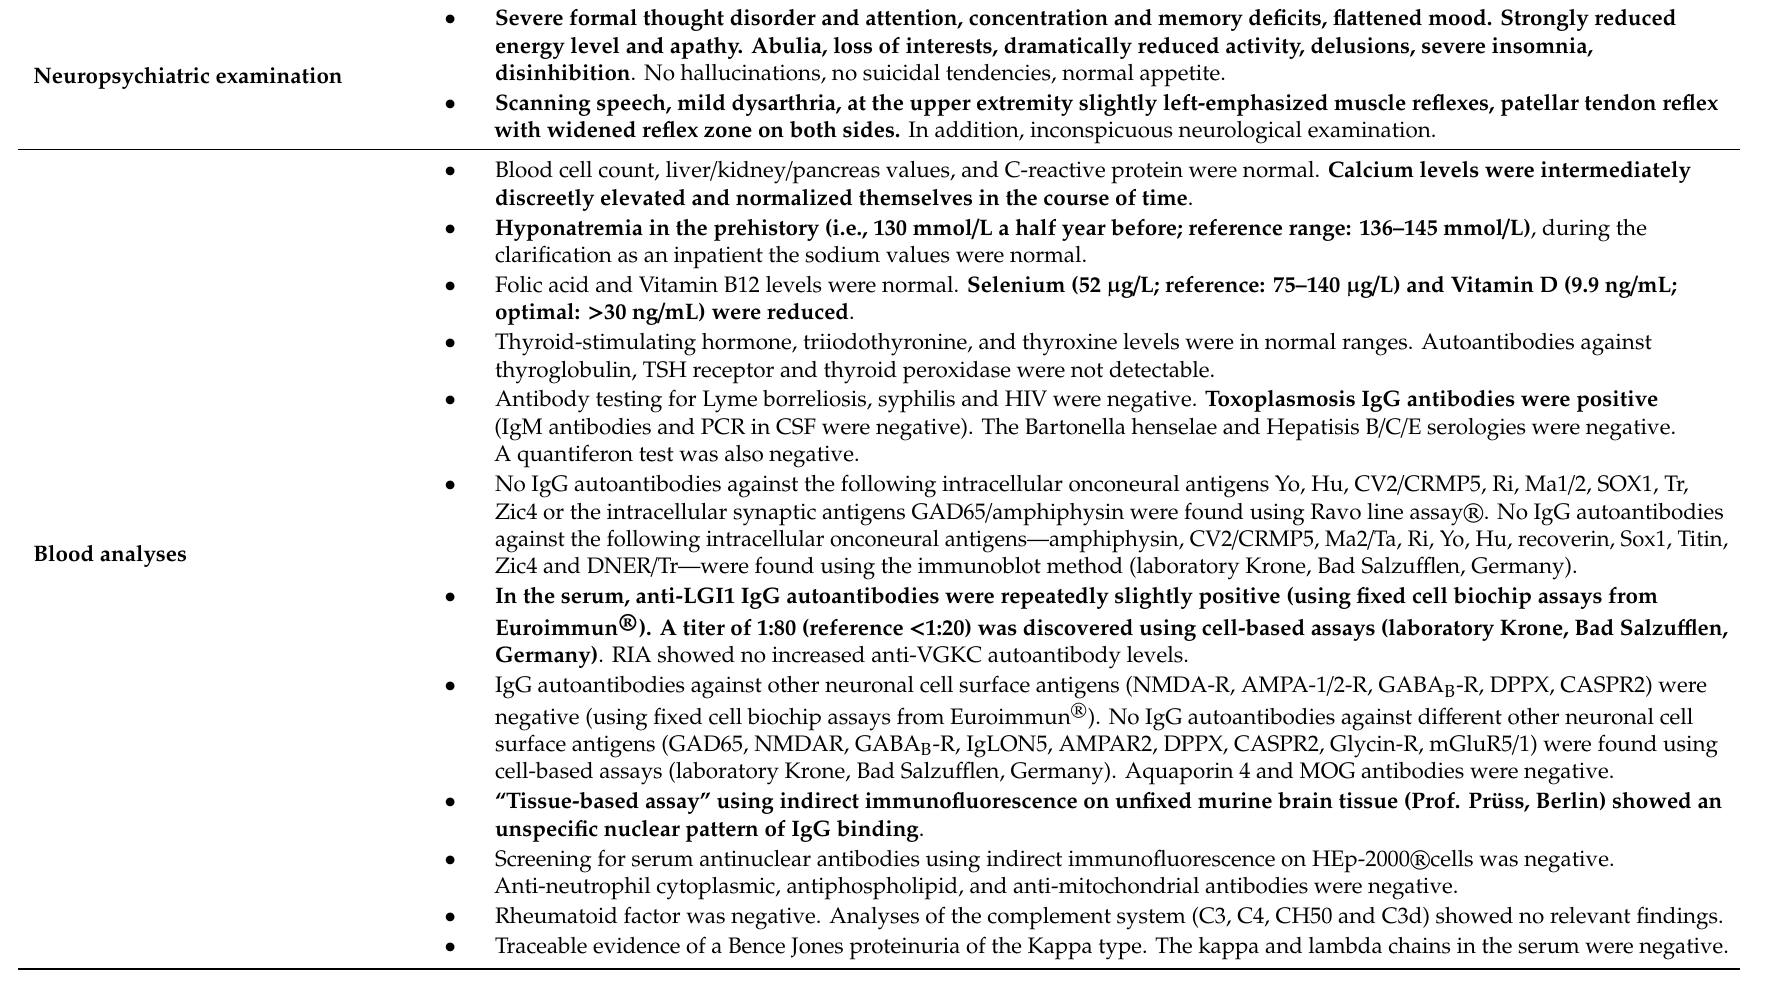
Table 1. Diagnostic findings approximately 1.5 years after symptom exacerbation. Abbreviation: FDG-PET, [ 18 F] fluorodeoxyglucose positron emission tomography.